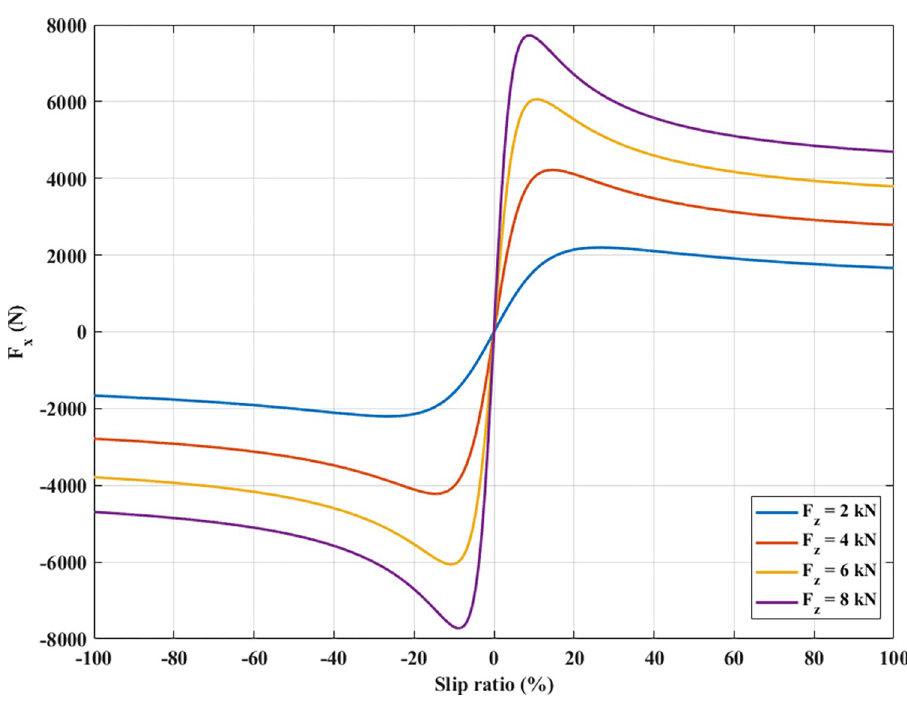
Fig 4. The longitudinal